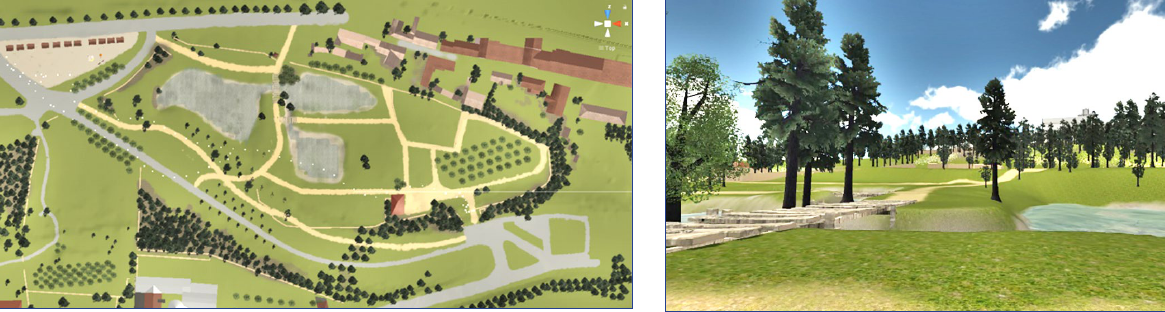
Figure 4. The game field of the game-based survey “Parkis”. The game map (on the left side) and the player view (on the right